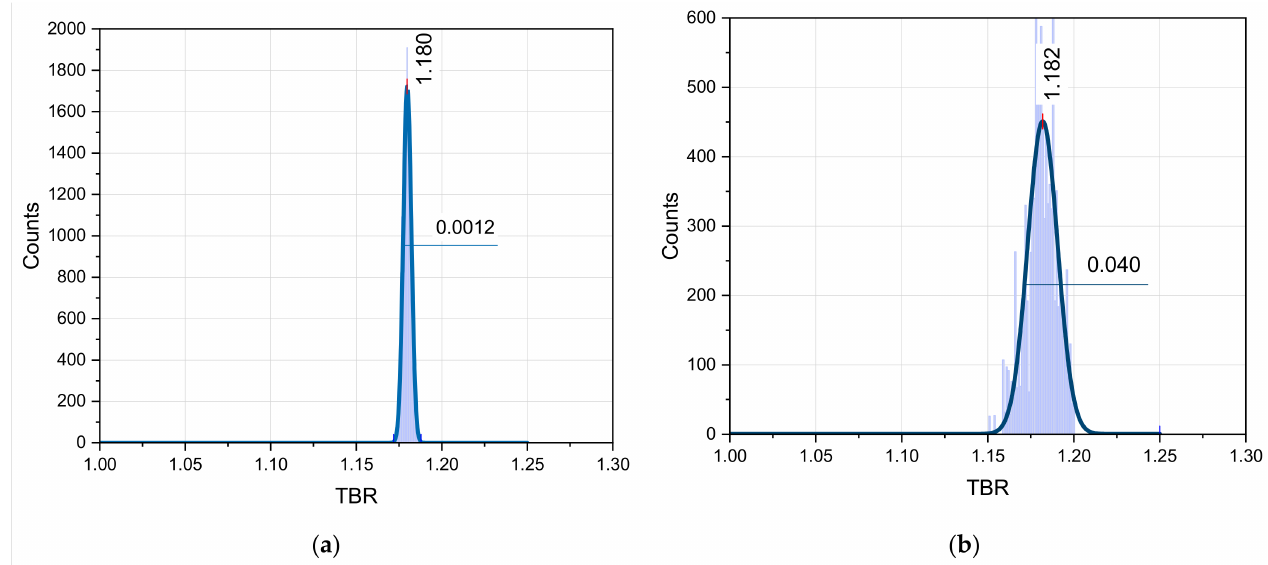
Figure 7. TBR statistical distribution with variated original n+ 6 Li data ( a ) and TBR statistical distribution with variated modified n+ 6 Li data ( b ).